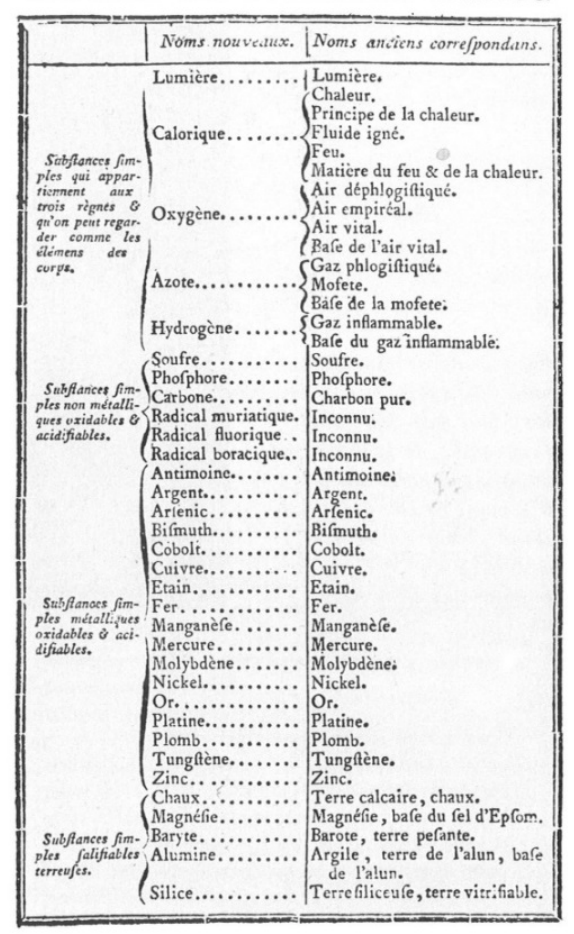
Figure 3. Lavoisier’s table of “simple substances” in his Traité Élé- mentaire de Chimie from